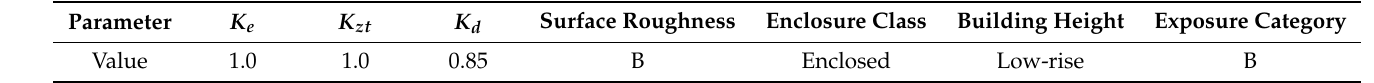
Table 5. Wind load parameters.